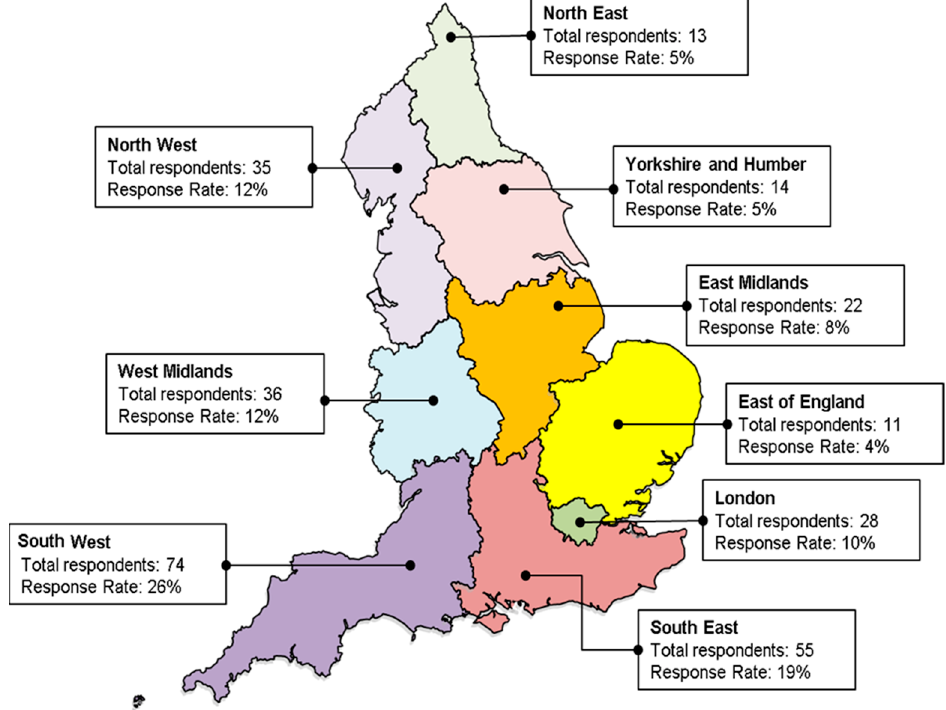
Figure 1. Survey response rate by area in England.